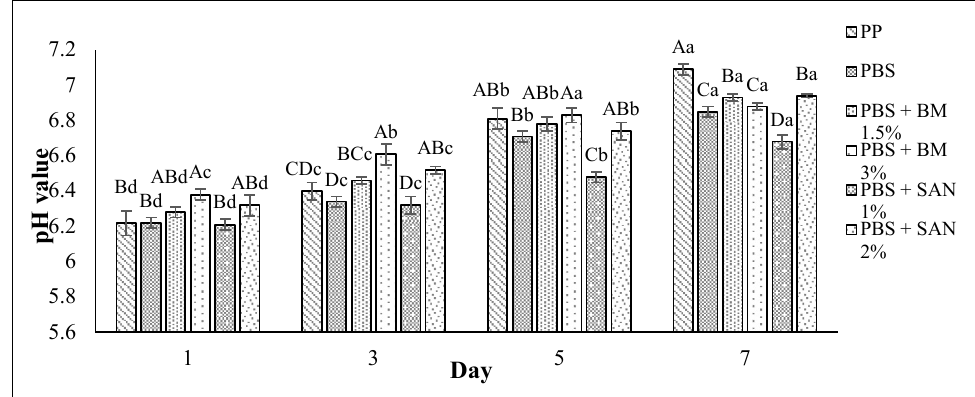
Figure 3. The pH values of chicken breast fillets stored in PP container and PBS film laminated tray during storage at 4 °C for seven days. Note: PP: polypropylene microwavable container (control); PBS: PBS film (untreated); PBS + BM 1.5%: PBS film + 1.5% Biomaster silver; PBS + BM 3%: PBS film + 3% Biomaster silver; PBS + SAN 1%: PBS film + 1% SANAFOR; PBS + SAN 2%: PBS film + 2% SANAFOR. Error bars indicate standard deviation (n = 3). The different A–F capital letters are significantly different ( p < 0.05) among treatment for each day. The different a–d lowercase letters are significantly different ( p < 0.05) among storage day for each sample.